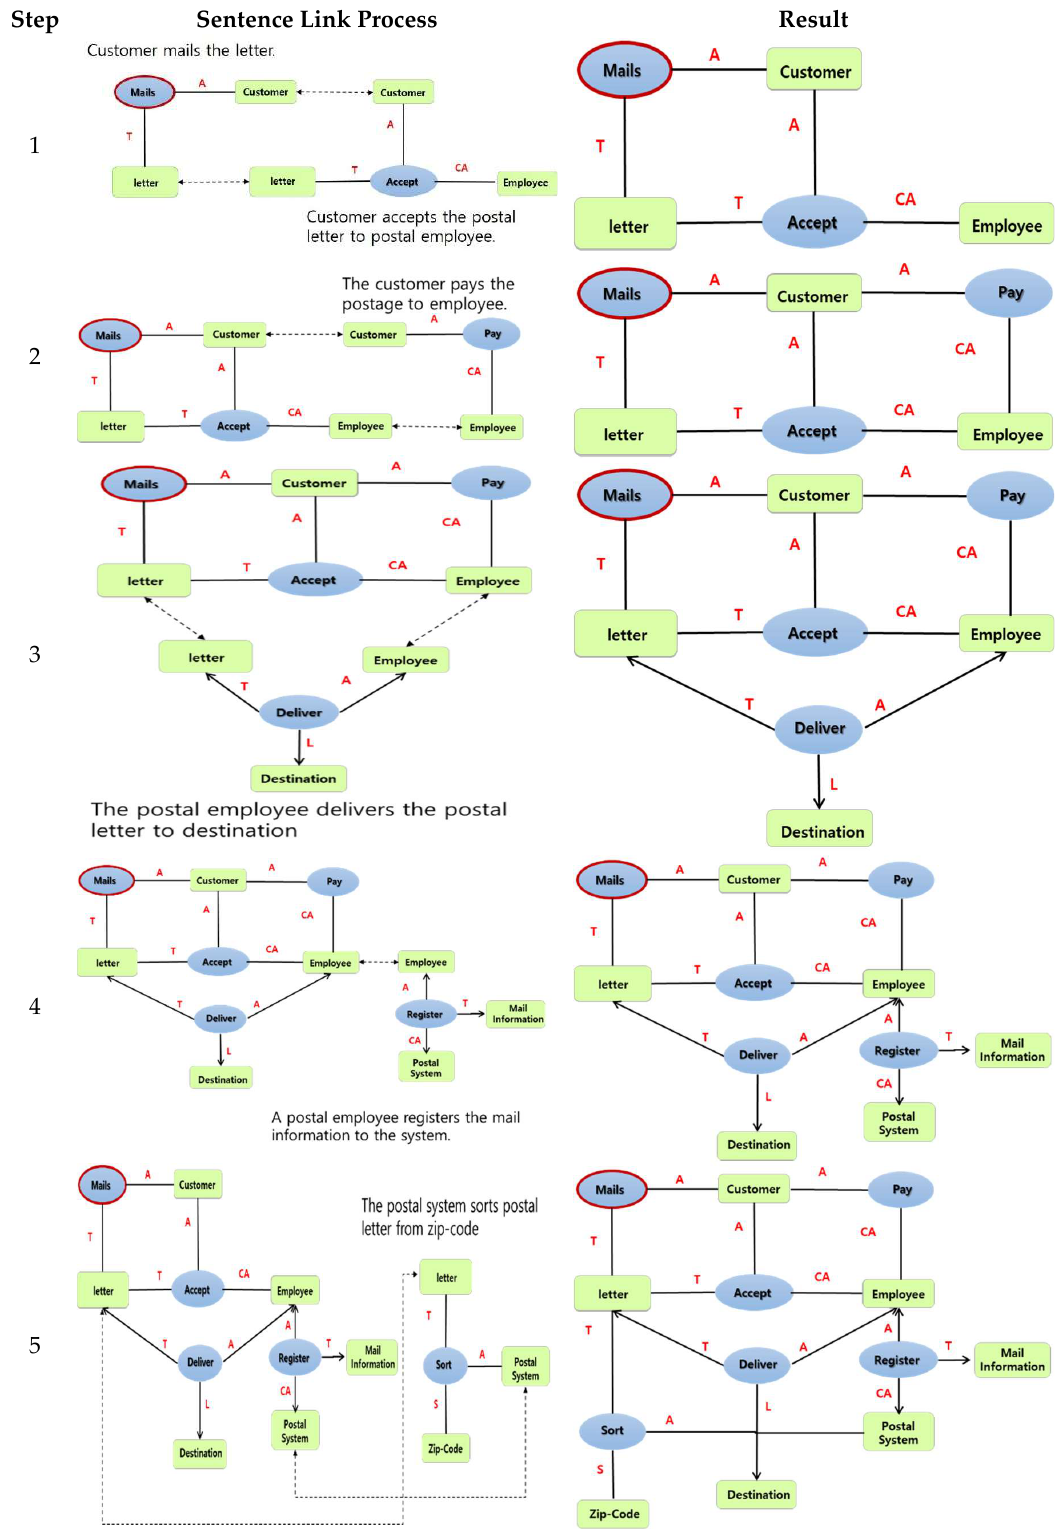
Figure 10. Related verb extractions.